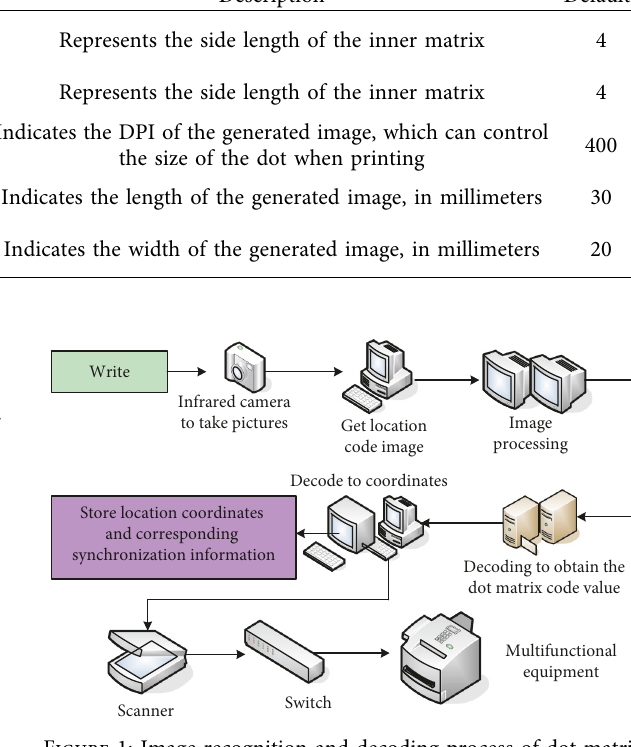
Figure 1: Image recognition and decoding process of dot matrix position